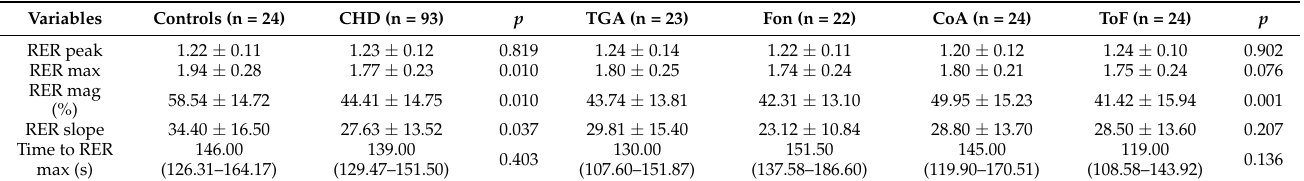
Table 3. Respiratory exchange ratio (RER) recovery parameters of the healthy controls as well as of the patients with congenital heart disease (CHD). Normally distributed variables are expressed with mean ± standard deviation and non-normally distributed variables are expressed with median and confidence intervals. Intergroup comparison was made between the four CHD subgroups and controls. TGA = transposition of great arteries; Fon = Fontan procedure; CoA = aortic coarctation; ToF = tetralogy of Fallot.